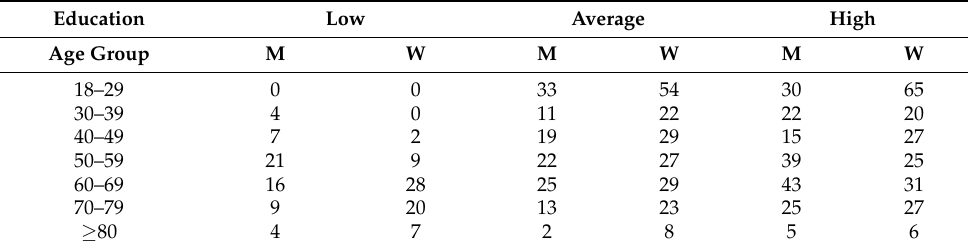
Table 2. Number of individuals per age group, stratified for education (into three groups) and sex (for descriptive